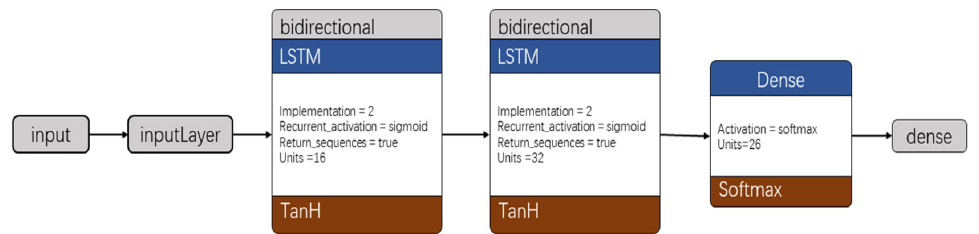
Figure 7. BiLSTM structure implemented for character recognition.